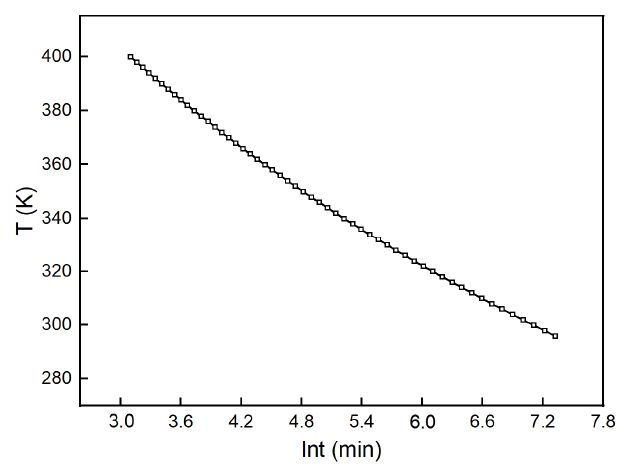
6 XDI/BES system.